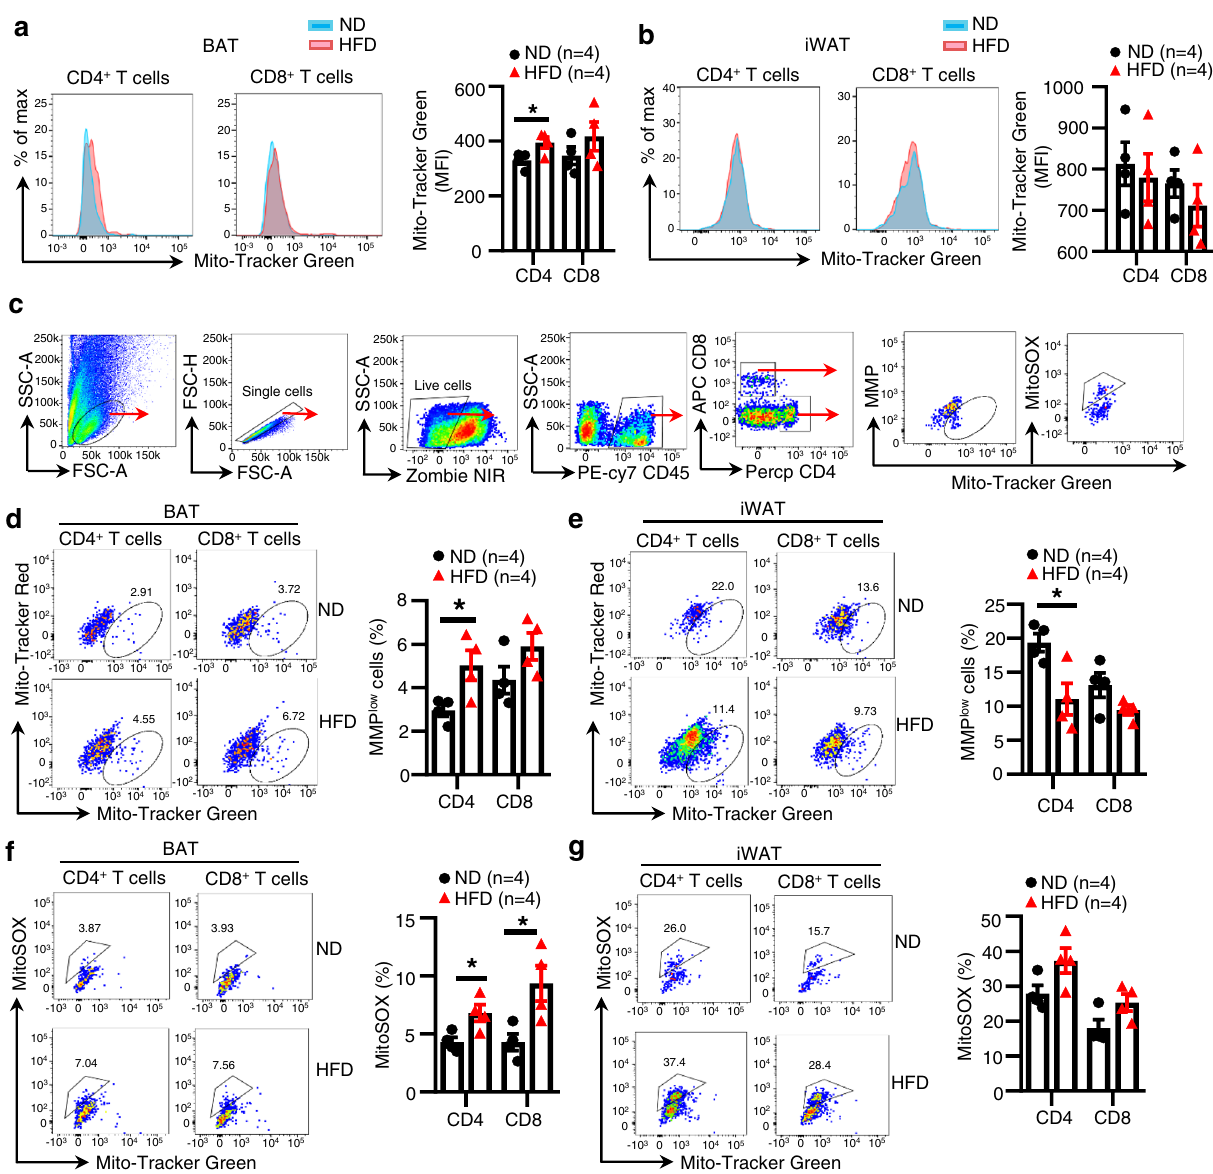
Fig. 1 HFD feeding downregulates T cell mitochondrial function in BAT. a , b Mitochondrial mass of T cells in BAT ( a ) and iWAT ( b ) from ND- and HFD- fed mice was analyzed by Mito-Tracker Green staining ( n = 4/group). c Gating strategies of mitoSOX-positive and MMP low T cells in BAT and iWAT. d , e MMP of T cells in BAT ( d ) and iWAT ( e ) from ND- and HFD-fed mice was analyzed by Mito-Tracker Green and Mito-Tracker Red staining. ( n = 4/ group). f , g Mitochondrial ROS of T cells in BAT ( f ) and iWAT ( g ) from ND- and HFD-fed mice was analyzed by MitoSOX staining. ( n = 4/group). Data shown are representative of three independent experiments. All data are presented as mean ± SEM. Statistical values p < 0.05 (*), p < 0.01 (**), p < 0.001 (***) are determined by two-tailed unpaired Student ’ s t -test. Source data are provided as a Source Data